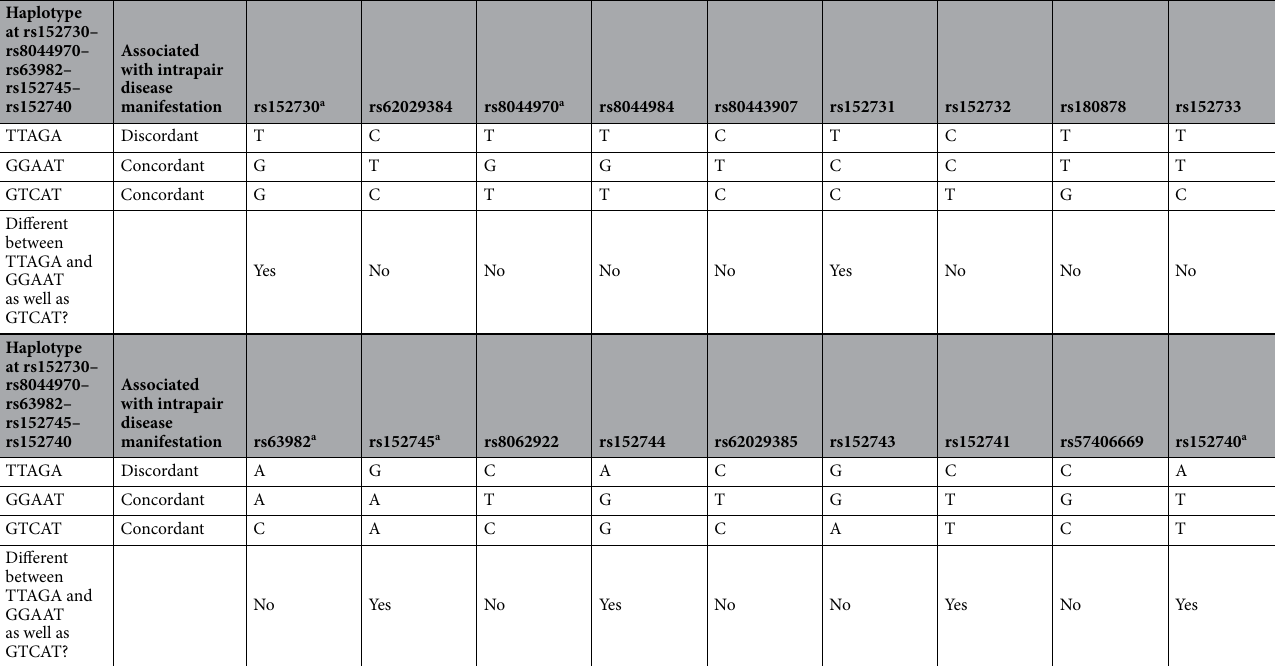
Table 2. Variants observed on contrasting haplotypes identified after Sanger re-sequencing of the 8000 bp genomic fragment defined by rs152730–rs152740 associated with intrapair discordance. a rs152730–rs8044970– rs63982–rs152745–rs152740 were used to map the fragment associated with intrapair discordance and define the contrasting haplotypes TTAGA (associated with intrapair discordance) and GGAAT as well as GTCAT (both associated with intrapair concordance); see Table